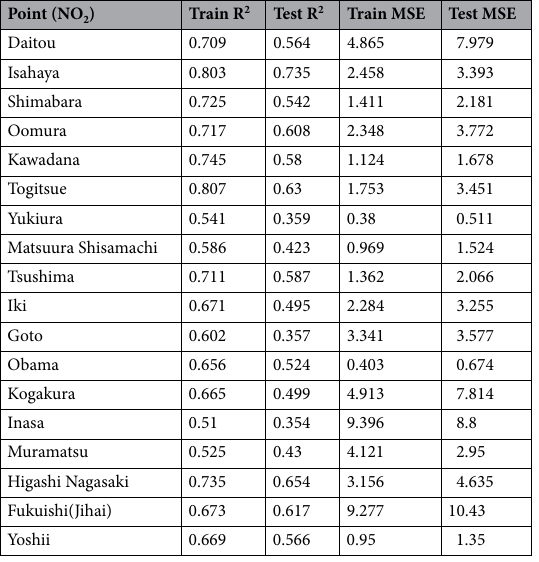
Table 4. Result of the random forest model for NO 2 using hyperparameters of the optimum